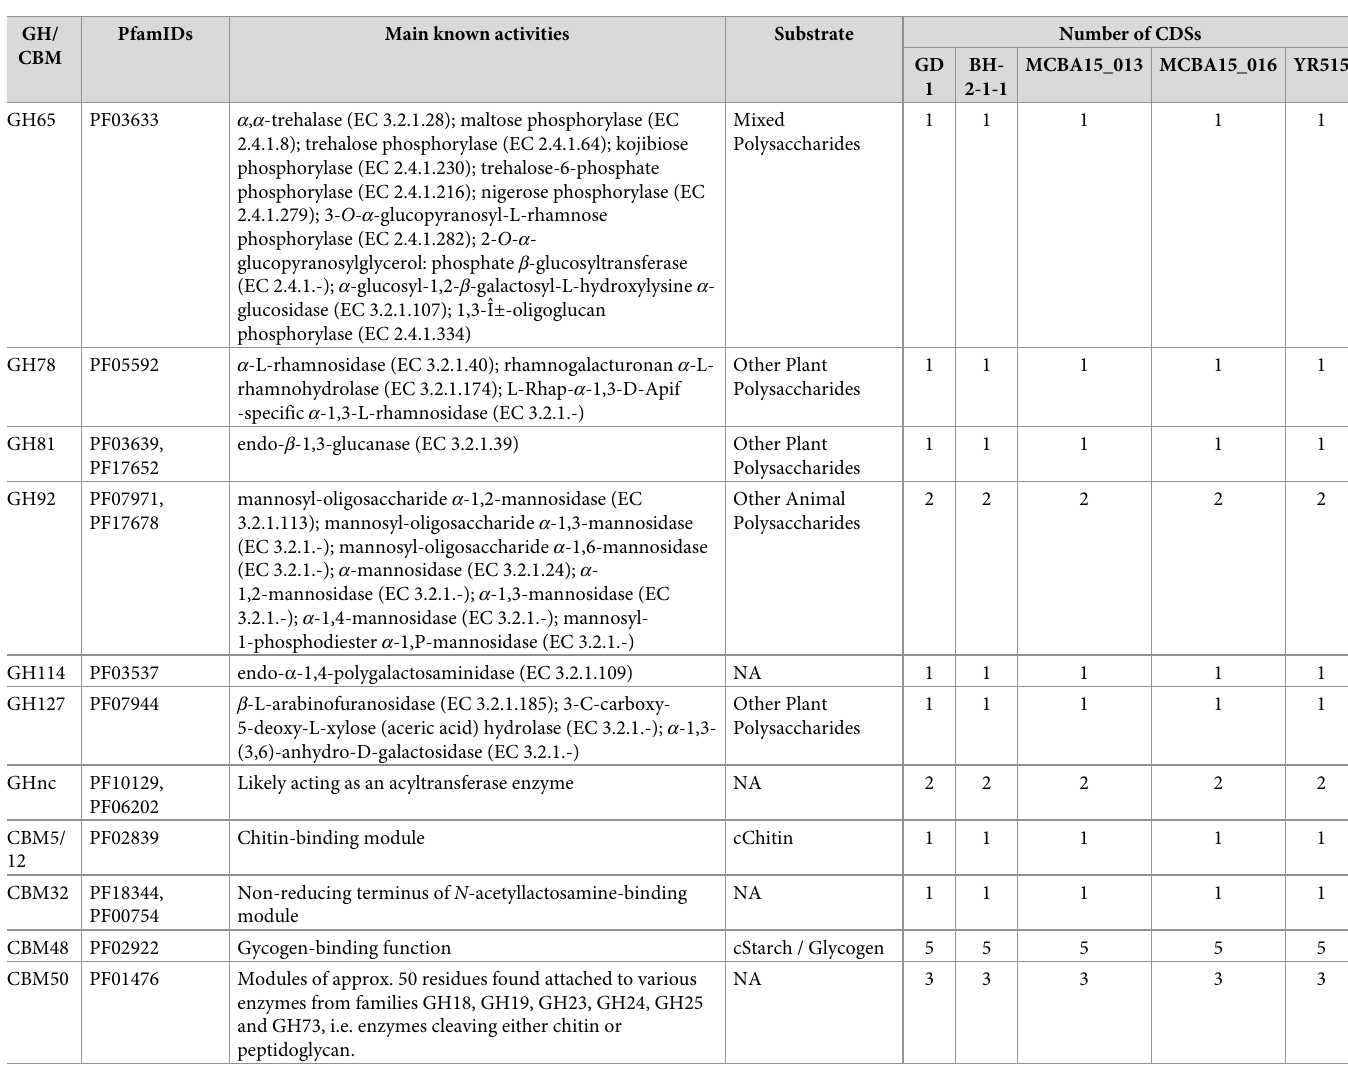
� highlighted rows indicated differences among the